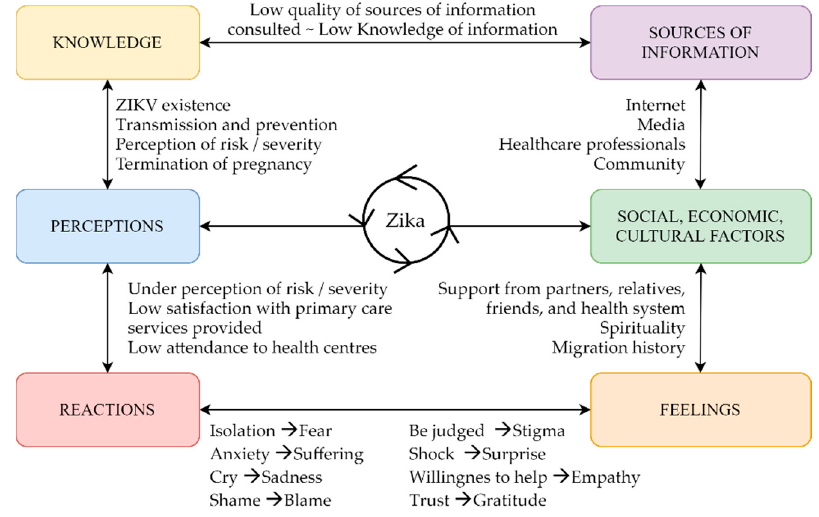
Figure 1. Connection of themes that arose during interviews with women diagnosed with ZIKV during pregnancy.